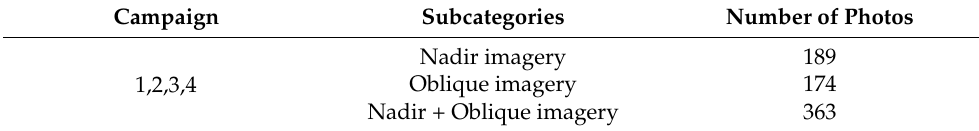
Table 3. Characteristics of subcategories.